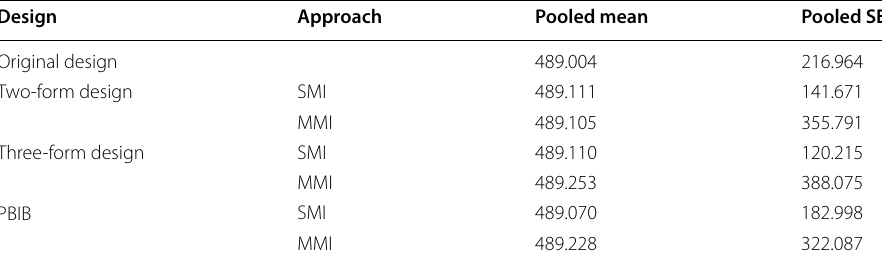
Table 5 Pooled mean and standard error of PVs Design